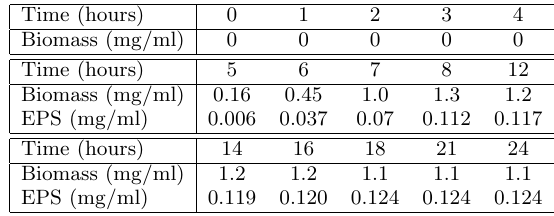
2 for EPS. The figures show clearly that the best production of EPS appears for a speed of 600 revolutions per minute. The experimental results corresponding to maximum EPS yield (at 600 rpm) are presented in Table I. The measurement error is estimated to be ≤ 15% for the biomass data ( ≤ 18% for the last three data) and ≤ 5% for the EPS data. Taking into account the measurement error, the experimental data of Table 1 are used in the modelling process as interval data [9]. For example, biomass data for hour seven is 1.0, hence the resp. interval value is 1 . 0 ± 15% = [0 . 85 , 1 . 15] . The interval data are visualized as vertical seg-